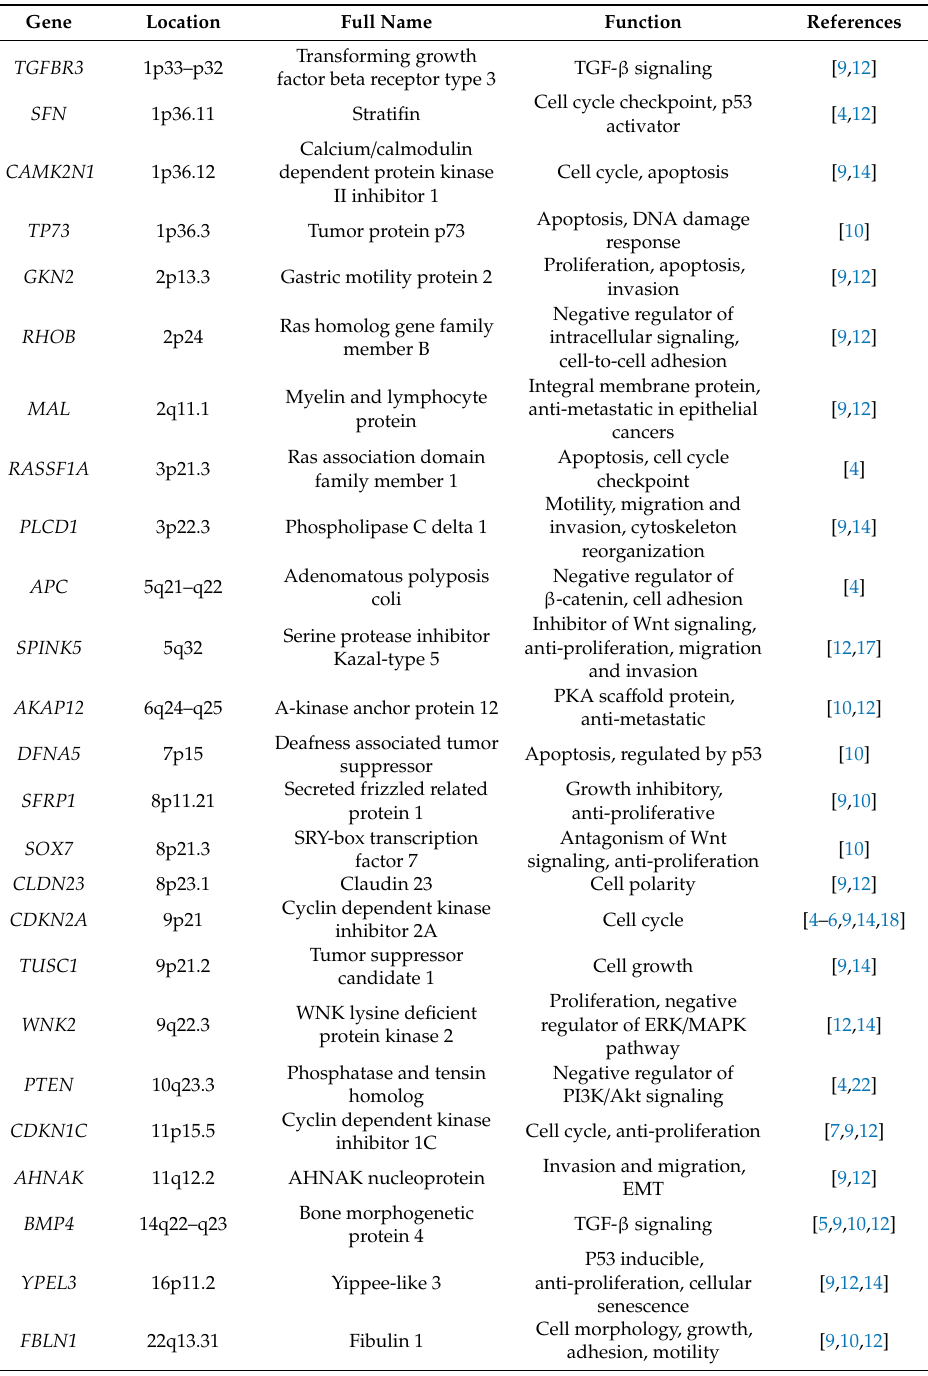
Table 2. TSGs silenced in EBVaGC. TSGs were identified using the TSGene Database of 1217 known TSGs. Lists of silenced and down-regulated genes from available data sets were cross-referenced and selected genes were present in multiple datasets as noted in the references